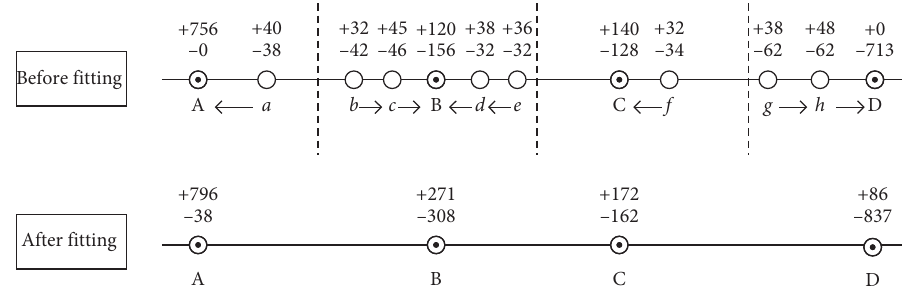
Figure 1: The fitting process of the number of passengers getting on and off the